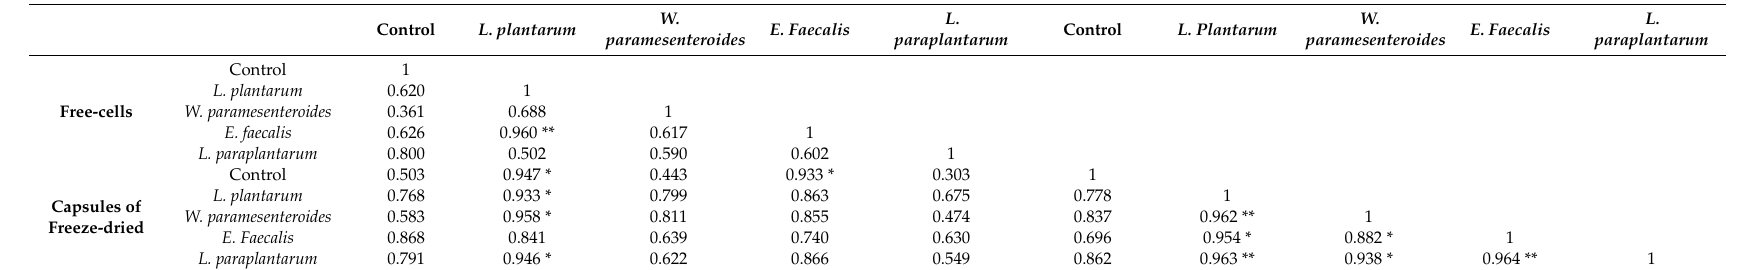
Table 5. Pearson’s correlation coe ffi cients between the capsules of freeze-dried and the free cells.